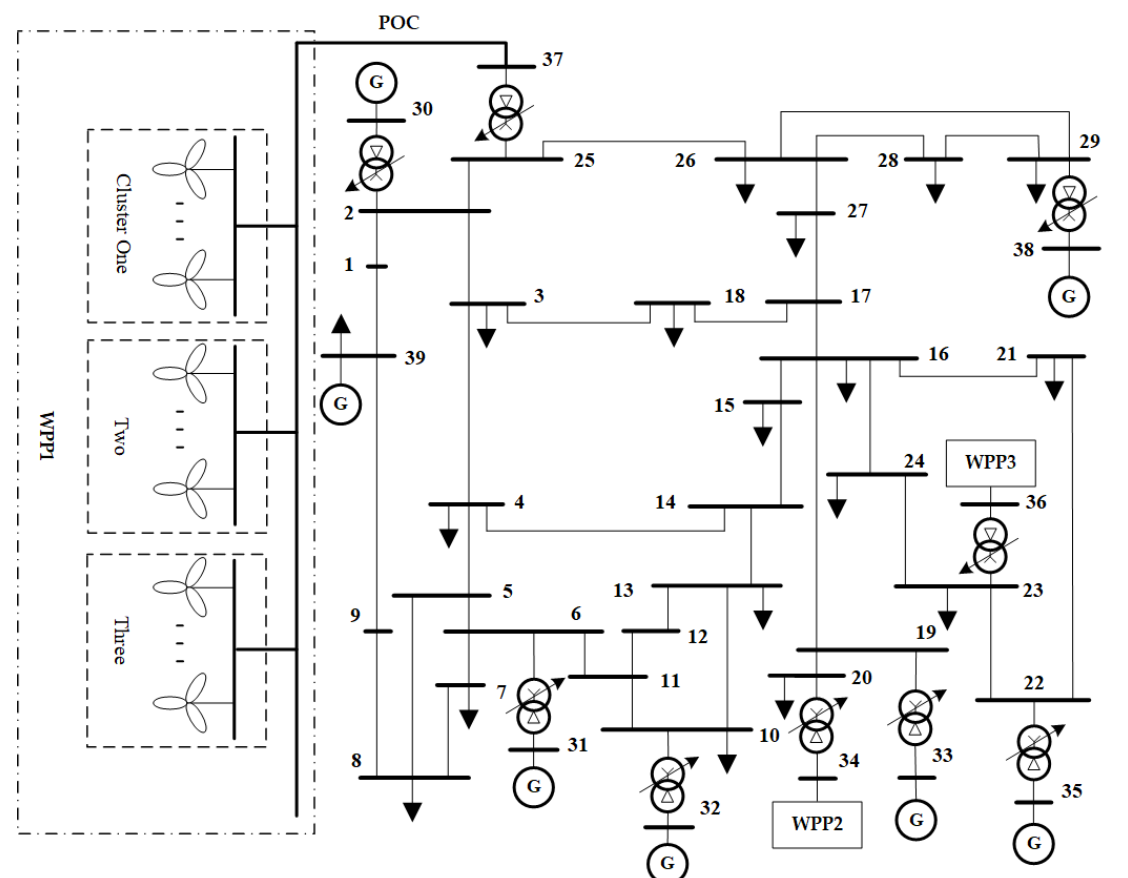
Figure 10. Modified IEEE 39 bus system topology. Table 3. D-PMSG parameters and settings of WPP1.